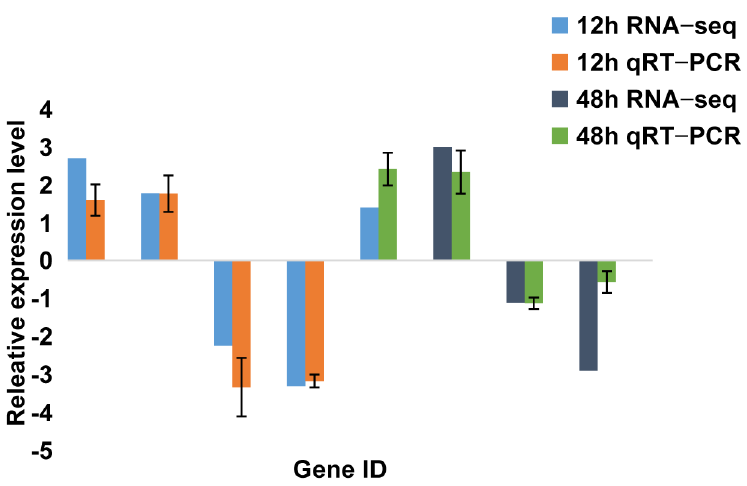
Figure 11. Results of qRT − PCR for Some Di ff erentially Expressed Genes in the Spleen.